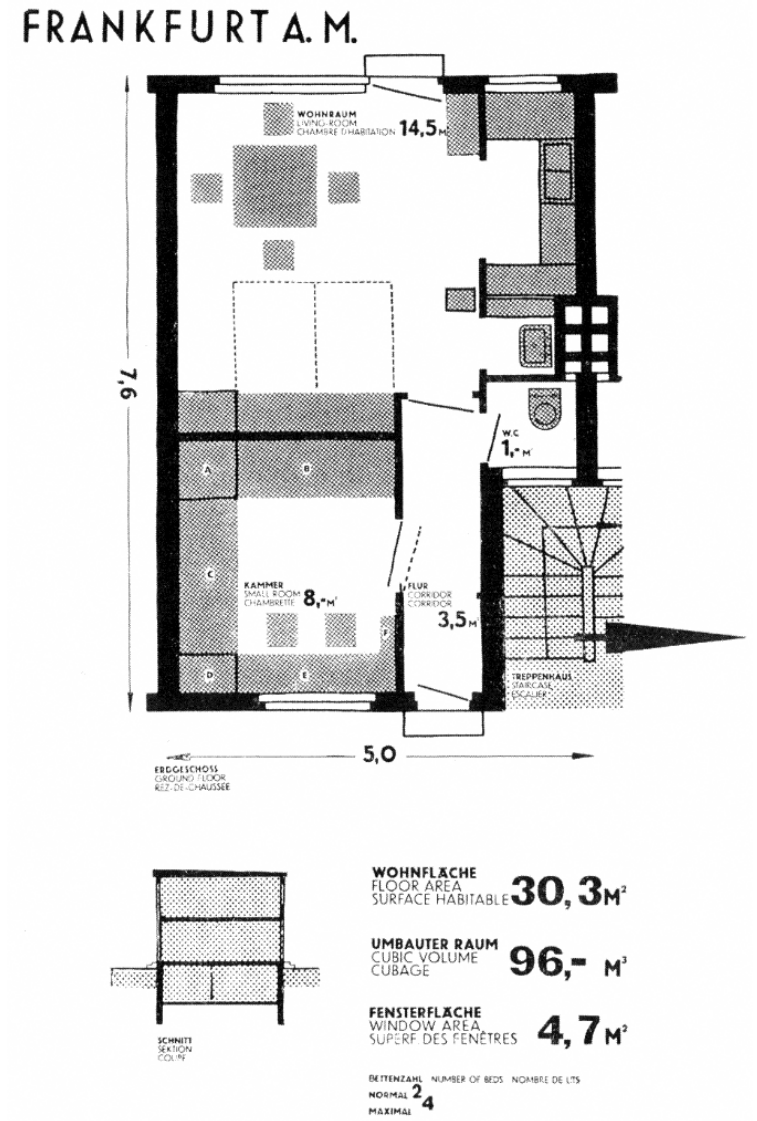
Figure 4. Dwelling type exhibited at the 2nd CIAM in Frankfurt with the foldable bed indicated with dashed lines. Source: Quiring, Voigt, Cachola Schmal, and Herrel